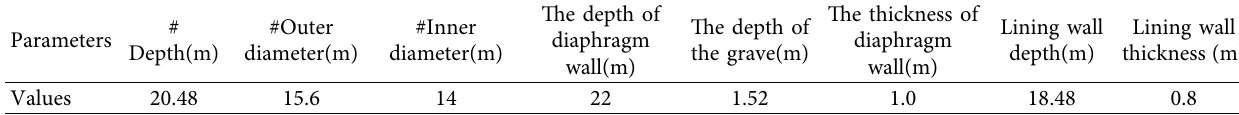
Table 2: The design geometry parameters of the shield TBM launching shaft.